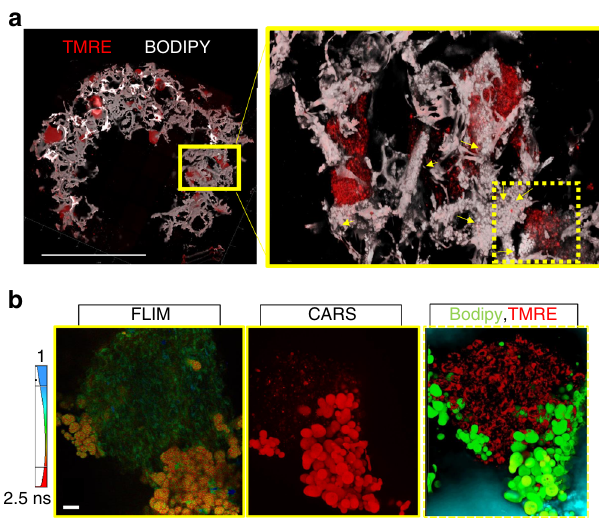
Fig. 8 Lipid droplets in glioblastoma cultured in 3D silk-HA-ECM constructs. a Spread of individual GBM spheres of varying sizes as indicated by TMRE staining, within the silk-HA constructs and a zoomed in area in the right panel, where droplets are visible as indicated by the yellow arrows. The droplets are white spherical structures against silk scaffold, which is also seen in white corresponding to the fl uorescence signal. Stitching and 3D rendering done to obtain the images. Scale bar, 2 mm. b Con fi rmation of the droplets visible within the silk-HA constructs to be lipid-containing, as indicated by an increased fl uorescence lifetime in comparison to GBM cells captured by 2-photon lifetime imaging (leftmost panel, one plane), by CARS signal targeting the C – H stretch shown for droplets (bright red) and cells (faint red) (middle panel), and by BODIPY staining of lipid droplets (green) against GBM cells stained by TMRE (red) captured by confocal imaging. CARS and confocal images are presented as maximal projections of 3D z-stacks to optimize visual contrast. Scale bar, 20 µ